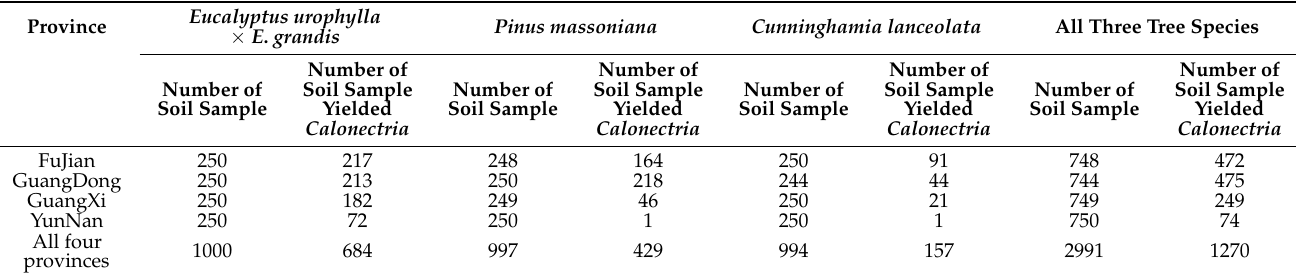
Table 5. Number of soil samples collected and Calonectria isolates obtained from plantations of three tree species in four